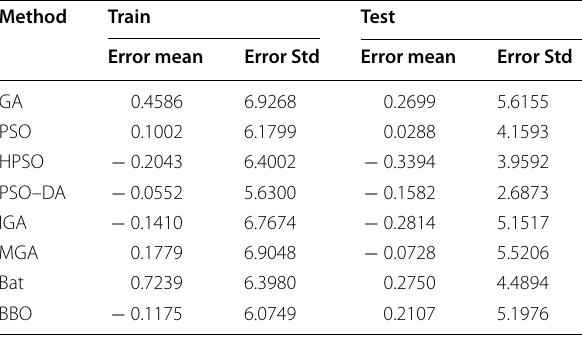
Table 6 Error mean and error std. for different